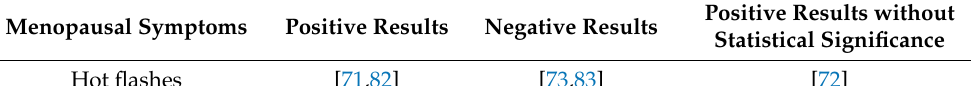
Table 3. Effects of n-3 LCPUFAs supplementation in menopausal depressive and cognitive symptoms and hot flashes: